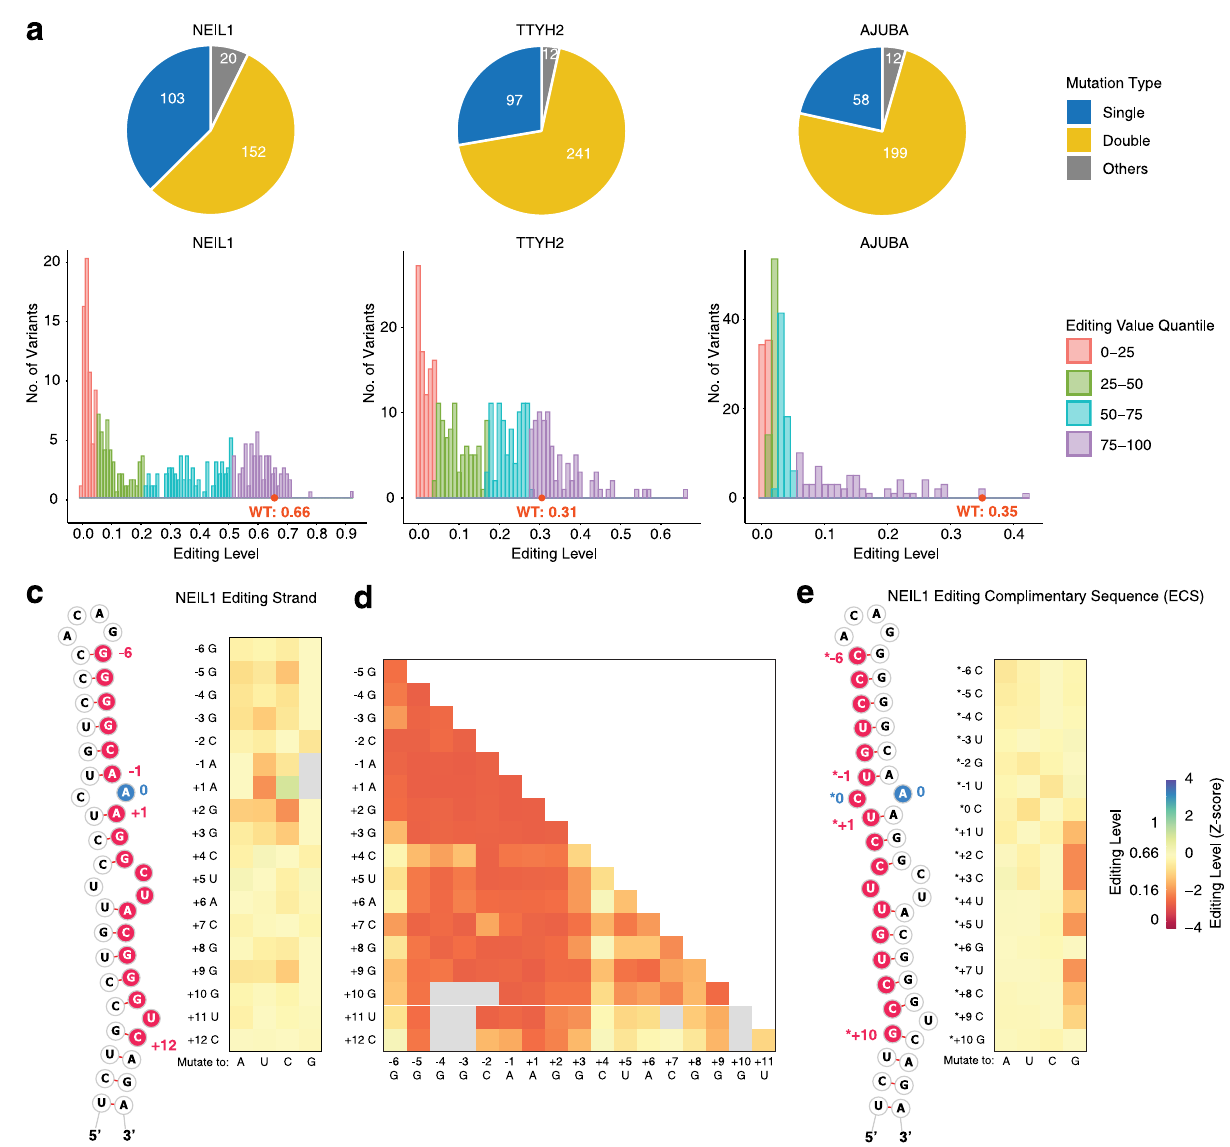
Fig. 2 RNA editing results from the targeted mutagenesis experiments. a Number of the types of mutations made in each targeted mutagenesis library, including single mutations (blue), double mutations (yellow), and other mutants such as indels (gray). b Distributions of editing levels for each targeted mutagenesis library, colored by editing level quantile in each RNA library. Pink, 25% quantile; green, 25 – 50% quantile; blue, 50 – 75% quantile; purple, 75 – 100% quantile. c , d Heatmap of editing levels from c single and d double mutations in the editing strand of NEIL1. e Heatmap of editing levels from single mutation in the editing complementary sequence (ECS) of NEIL1. Editing level of WT NEIL1 is 0.66 ± 0.06. The Z -score is calculated as described in “ Methods ” and the WT editing level Z -score is 0. c – e shares the same heatmap color scale shown in e , re fl ecting average editing level from six biological replicates. In c and e , the mutagenized region is highlighted in red and the editing site in blue in the partial illustration of the secondary structure of NEIL1